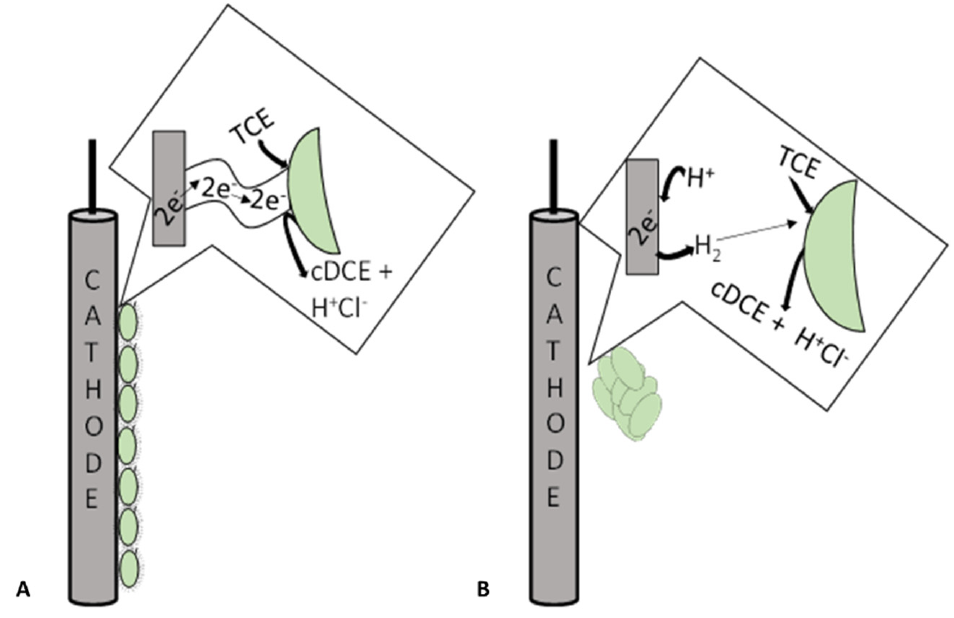
Figure 5. Schematic representation of dechlorinating microorganisms’ activity through direct ( A ) or indirect ( B ) mechanisms on the biocathode.